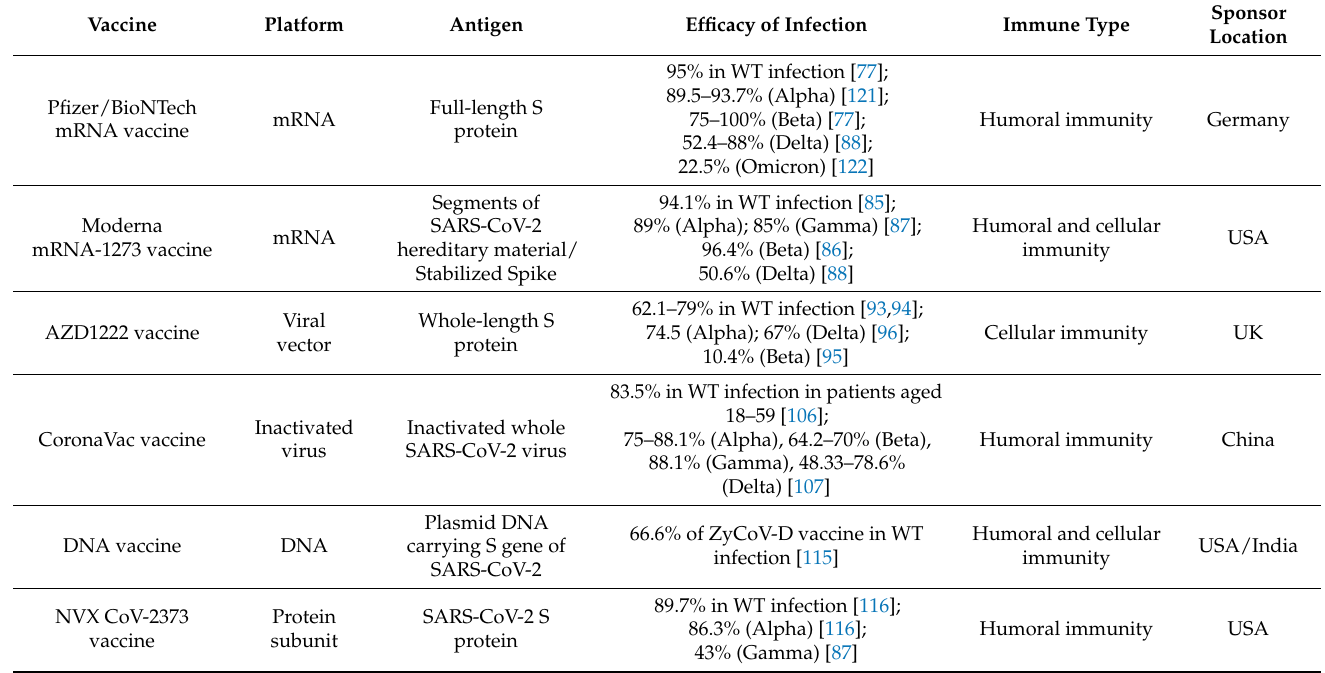
Table 2. Basic information of current